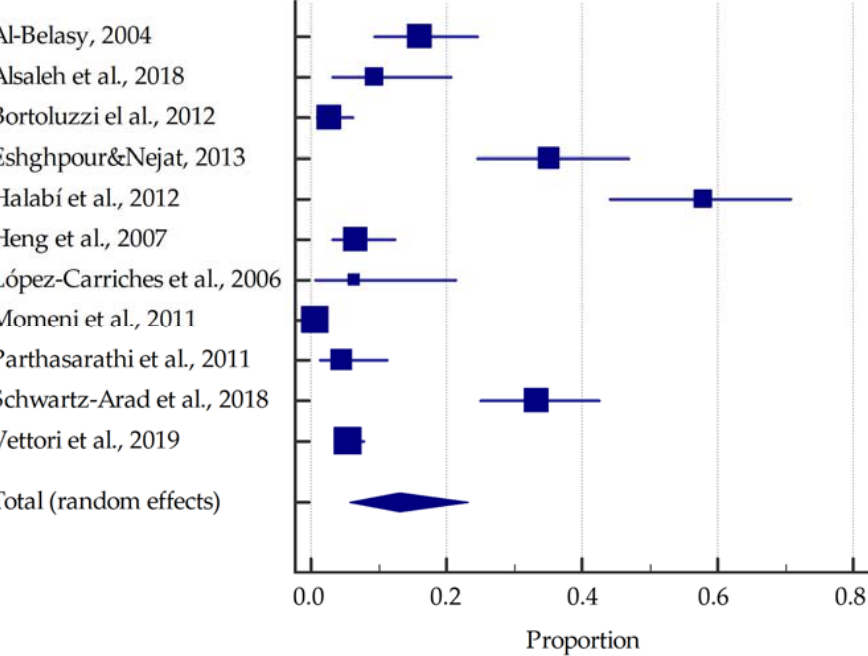
Figure 3. Forest plot presenting the summarised prevalence of dry socket among smokers [21–31].